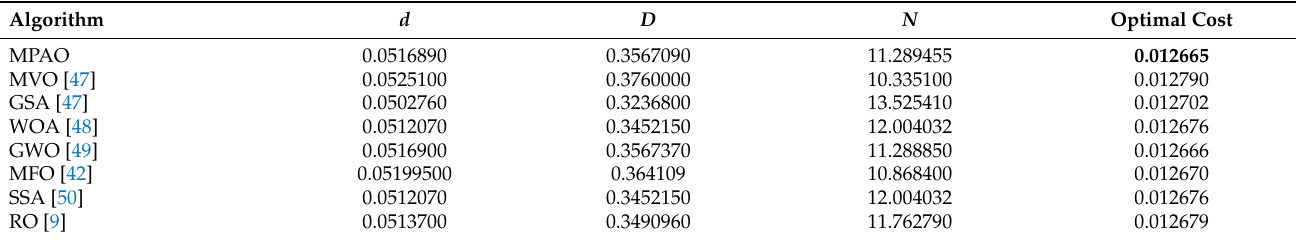
Table 15. Results of the Tension/Compression